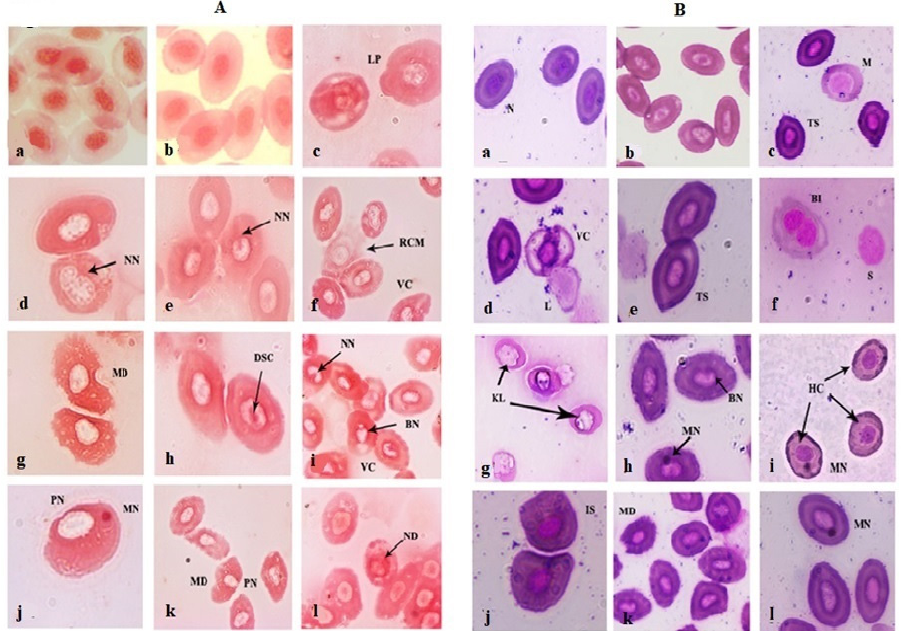
Figure 4. Effects of florfenicol dosing at 15 (1 × ) and 45 mg kg biomass − 1 day − 1 (3 × ) for 10 consecutive days on the erythrocyte morphological characteristics of Oreochromis niloticus juveniles on day 10 FD (1 × : c–e; 3 × : f–h) and day 21 PFD (1 × : i,j; 3 × : k,l) and compared with the control group (a,b). N: